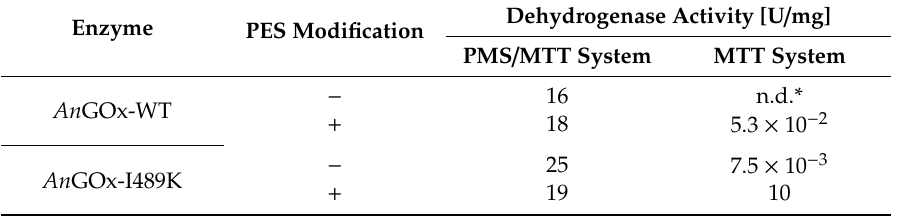
Dehydrogenase activity of unmodified and phenazine ethosulfate (PES)-modified glucose oxidases (GOxs) (wild-type; WT and mutant; I489K) determined with the phenazine methosulfate (PMS) / 3-(4,5-dimethyl-2-thiazolyl)-2,5-diphenyl-2 H -tetrazolium bromide (MTT) system and MTT system.